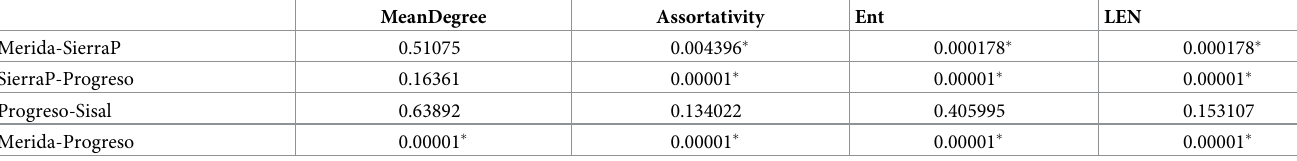
Table 6. P-values of t-tests performed for neighboring cities for each metric of the networks presented in Table 5.